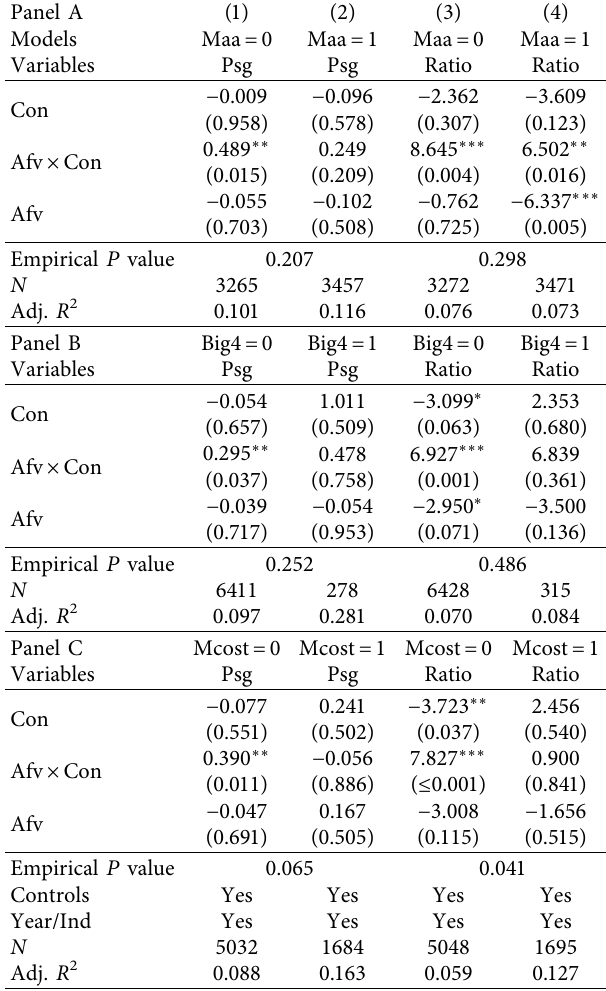
Table 10: The impact of external supervision on the adjustment of fair value